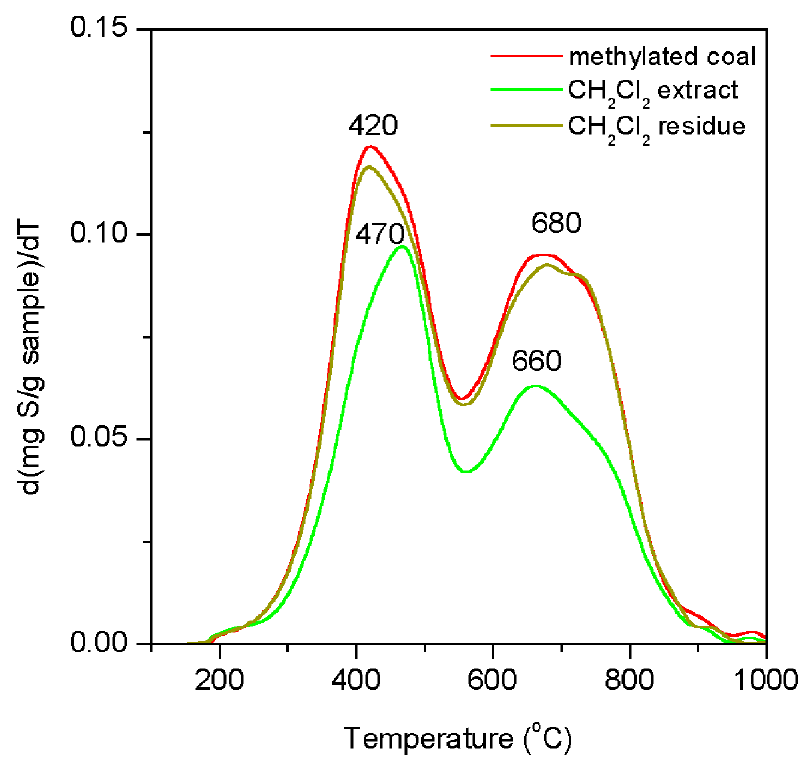
Fig. 6 AP-TPR kinetograms of Mequinenza coal methylated in K/NH 3 system and products of its